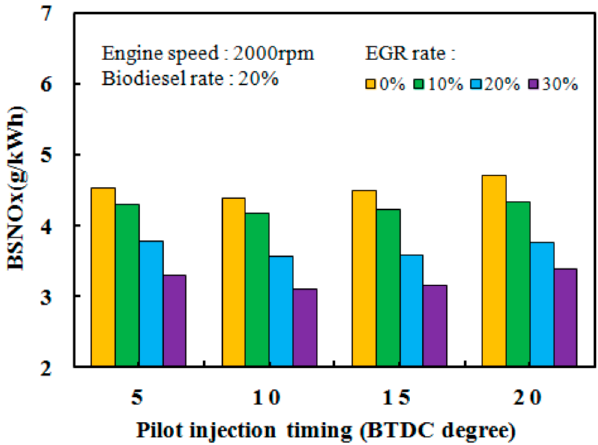
Figure 18. BSNO x (brake specific nitrogen oxides) of BD20 at various pilot injection timings and EGR rates.